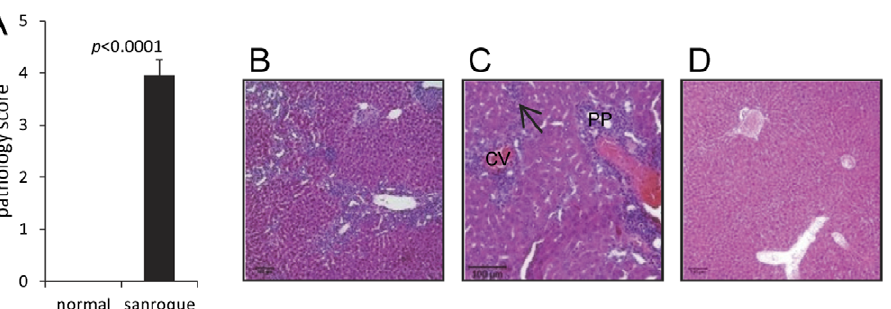
Figure 2. Roquin san/san mice have chronic hepatitis. ( A ) Average pathology score of normal and Roquin san/san mice. Mean 6 SEM of 6 normal and 26 Roquin san/san mice ages 15–55 weeks. ( B, C ) Representative H&E stained tissue sections of the liver from Roquin san/san mice with pathology scores of 5. ( C ) Mononuclear cell infiltrates are seen distributed in the periportal area (PP) and around the central veins (CV) of the hepatic lobules. Focal areas of hepatocyte necrosis (arrows) with mononuclear cell infiltration is found in the mid-zonal and pericentral areas of the hepatic lobules. ( D ) A